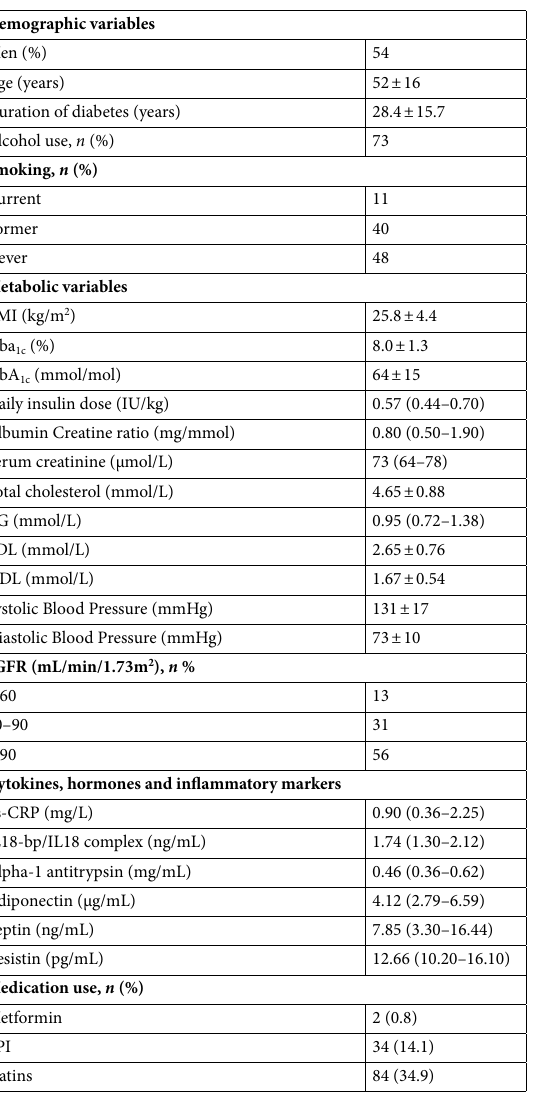
Table 1. Characteristics of individuals with type 1 diabetes in the DM300 cohort ( n = 241). Characteristics are presented as n (%), or mean ± SD, or median (interquartile rang). BMI = Body Mass Index, HDL = high density lipoprotein, hs-CRP = high-sensitivity C-reactive protein, IL18-bp = interleukin18-binding protein, PPI = proton pump inhibitor, TG =